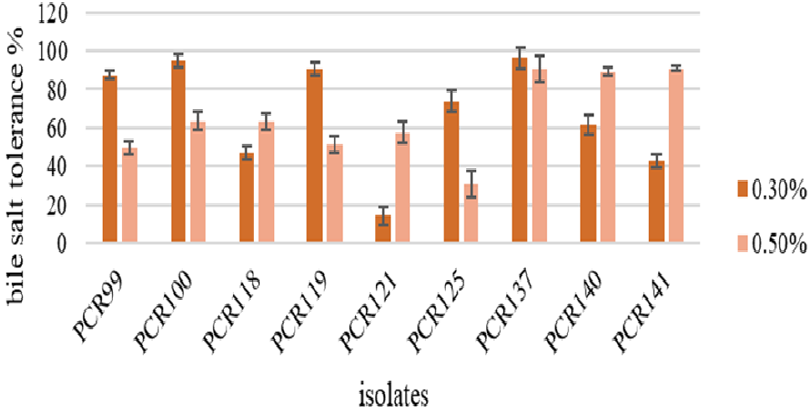
Figure 2. Detection of Bile Salt tolerance in bacterial strains. Values are means of replicate experiments; ± indicates standard deviation from the mean. Values differs significantly ( p < 0.05).